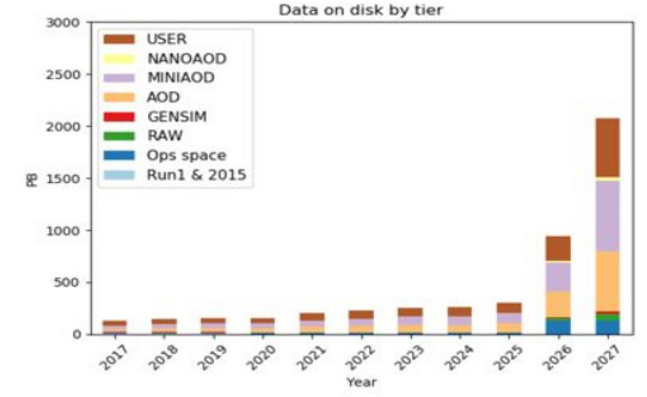
Estimated CMS annual disk requirements compared to past and current ones Fig. 1. ​ A primary objective in this R&D phase is to study how to optimize data usage and access for the end user analysis cases; the production data (MonteCarlo generation and data reprocessing/reconstruction) are still meant to be managed by a higher-level